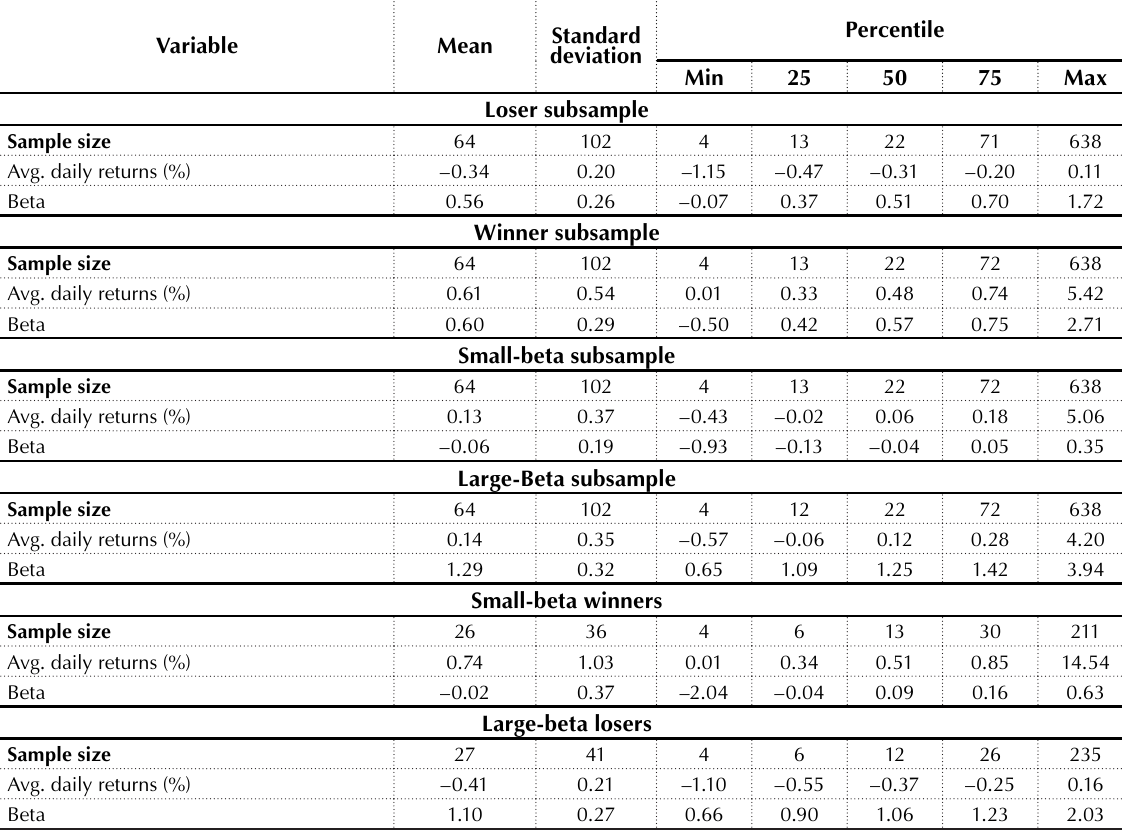
Table 2. Descriptive statistics for different